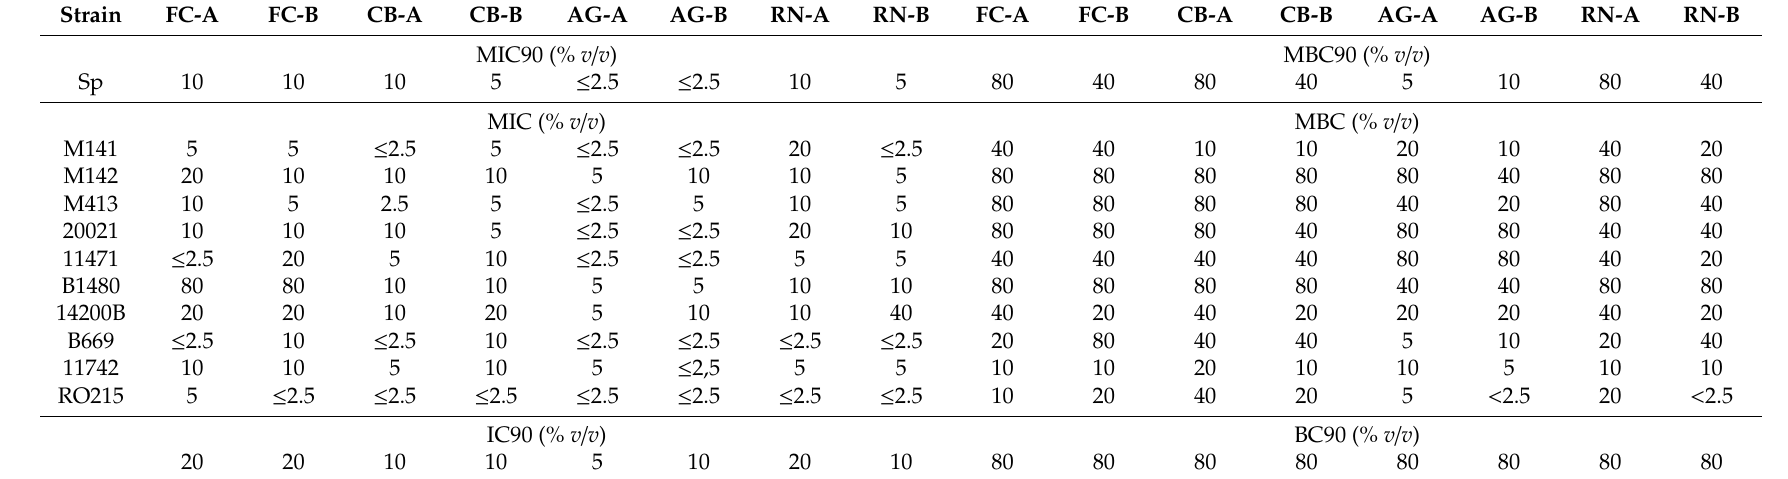
Table 5. MIC and MBC values of C-GMs vs. S. pyogenes and probiotic